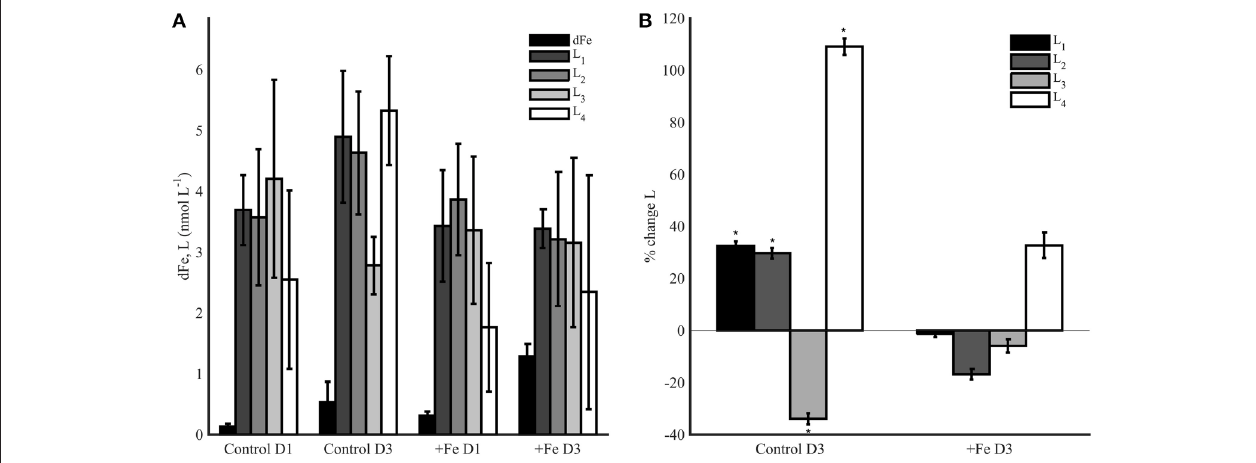
FIGURE 5 | (A) The dFe (black bars), L 1 (dark gray bars), L 2 (gray bars), L 3 (light gray bars), and L 4 (white bars) ligand concentrations from incubation experiment 2 in controls (left) and + Fe treatments (right) on day 1 (D1) and day 3 (D3). Error bars represent the standard deviation from replicate bottles for the control (A, B, C) and + Fe (FeA, FeB, FeC) treatments. (B) Average percent change in ligand concentrations from day 1 to 3, where * indicates a significance difference in the percent change in ligand concentrations from day 1 ( t- test, p < 0.05